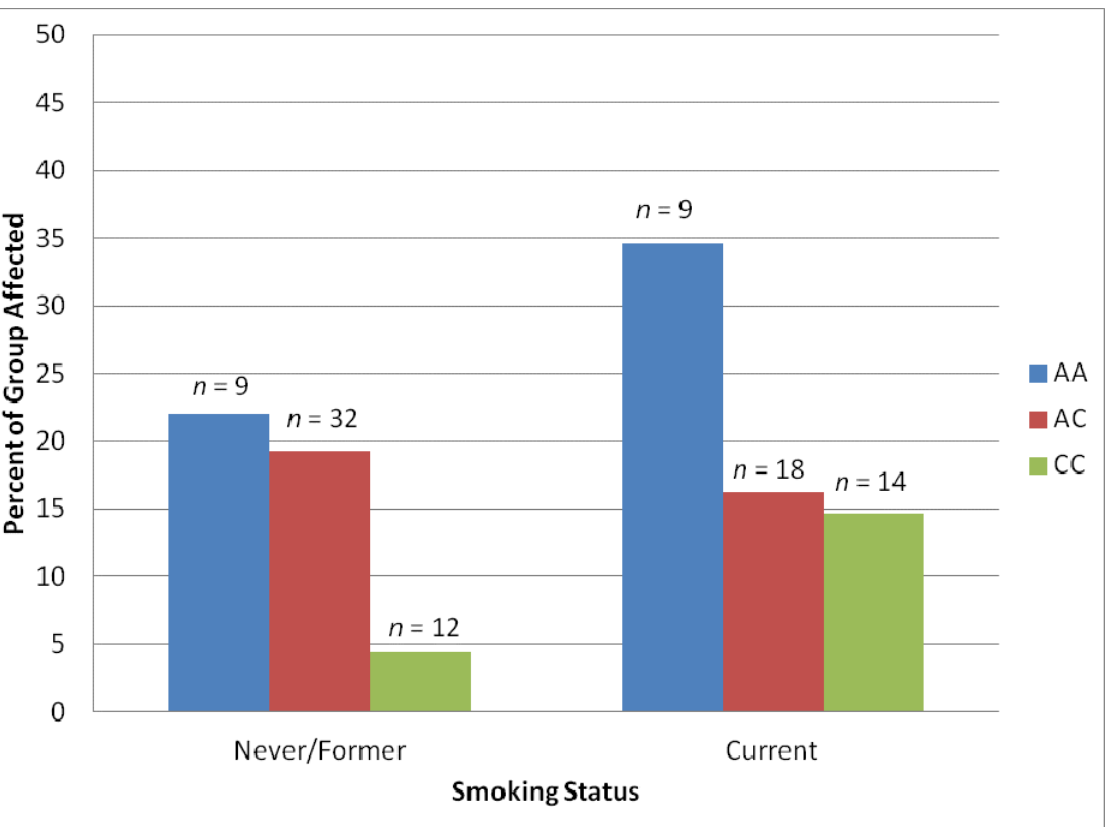
Figure 3. Percents of persons within groups defined by both smoking status and rs3870371 genotype who are affected